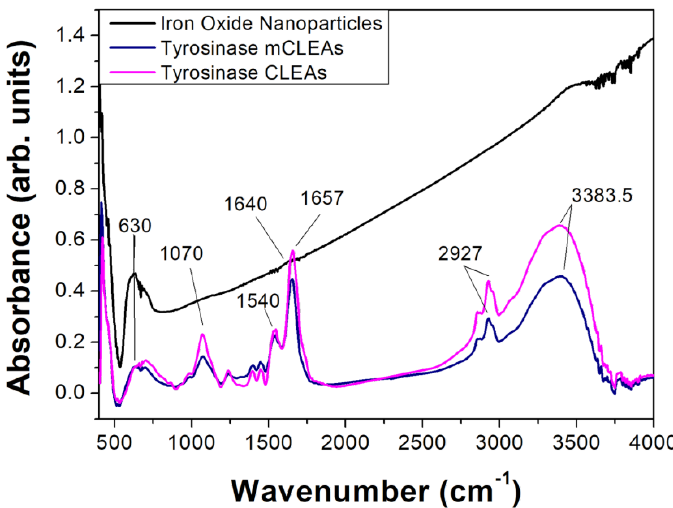
Figure 1. FTIR spectra of magnetic nanoparticles, tyrosinase CLEAs and tyrosinase mCLEAs.